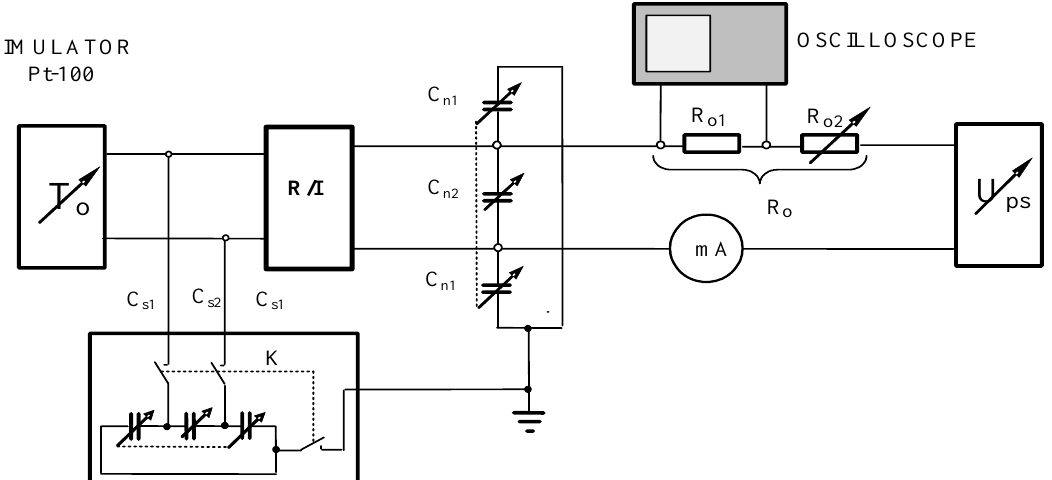
Figure 12. Laboratory experimental circuit of temperature measurement line with the possibility of taking account capacities of the Pt-100 sensor and connecting cables, where: R / I—second-order inertial transmitter, mA—DC ammeter, U ps —source of voltage, Ro—equivalent of all resistances in the 4–20 mA current loop, C s1,2 —equivalents of own capacities of Pt-100 sensor, C n1,2 —equivalents of own capacities of cables, K- switch.